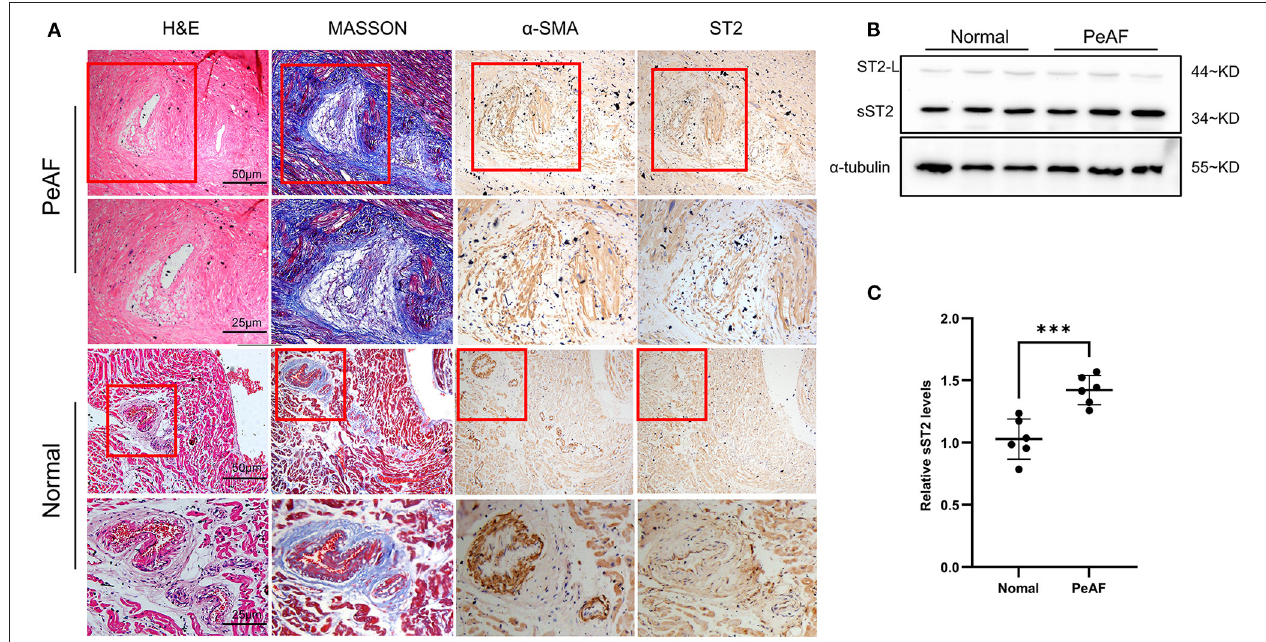
FIGURE 5 | Enhanced sST2 production in atria from persistent AF patients. Representative images of Masson, HE, and immunohistochemistry (IHC) staining ( α -SMA and sST2) in atria from persistent AF patients and sinus rhythm (SR) controls at low and high magnifications (A) . IHC staining showing that sST2 and fibrotic tissues are restricted in the similar areas (indicated by red squares) (A) . The content of ST2 in atria was measured by Western blotting (B) . Quantitation is shown in (C) . PeAF, persistent AF. *** P < 0.001 vs.